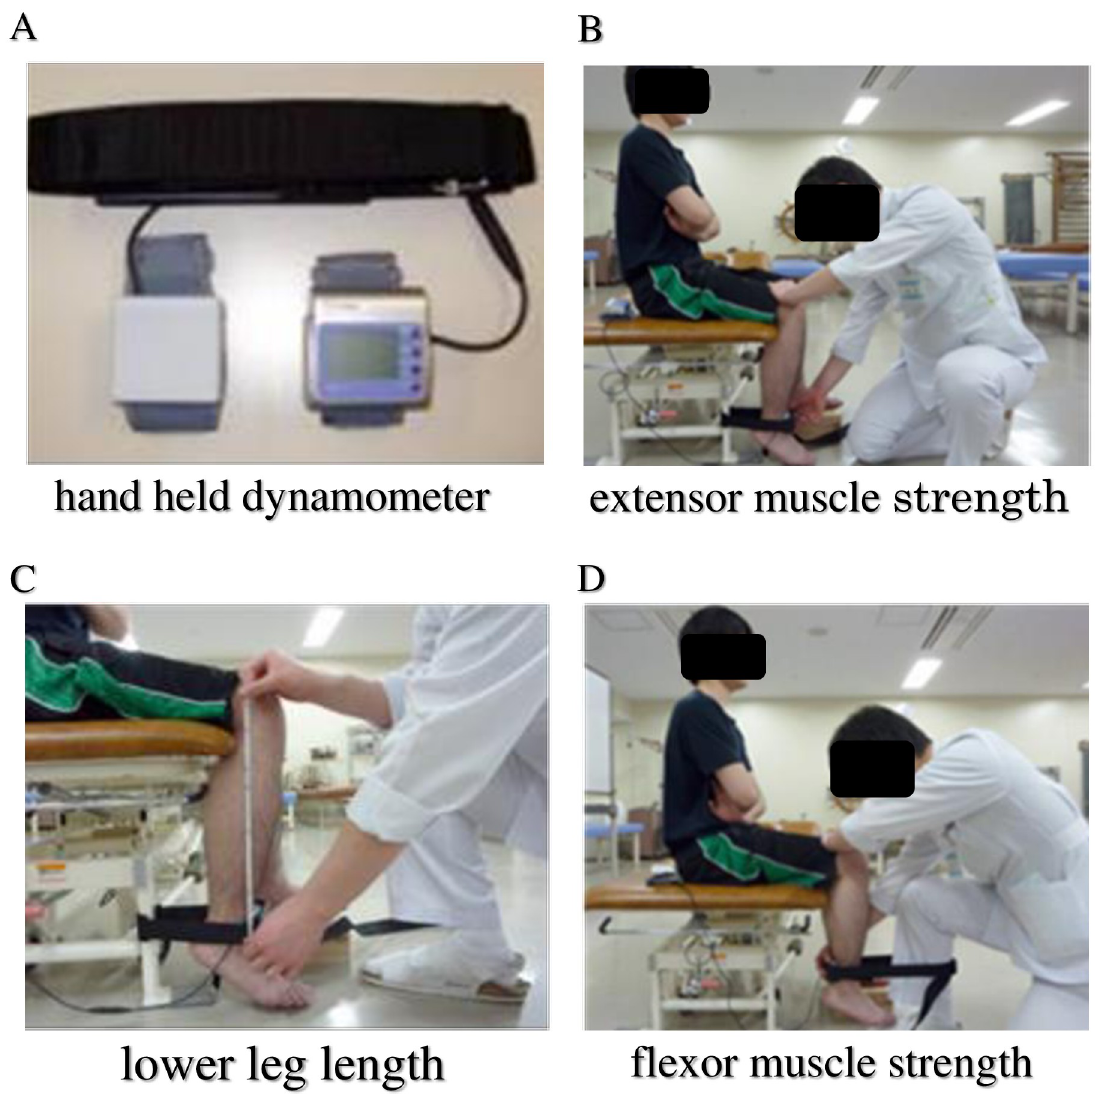
Fig 2. Measurement of knee extensor/flexor muscle strength. The measurement was performed by use of a hand-held dynamometer (HHD) [A]. For measuring extension muscle strength [B], the examinee sitting on chair with the knee joint bent at 90-degree angle was asked to extend the lower leg at maximum force against the black belt around the ankle, which was fixed behind to the chair with the HHD attached to its front. The length of the lower leg (Len in meter) was measured [C] as a distance between the lateral cleft of the knee joint and the center of the HHD sensor at the ankle. The muscle strength in N � m was computed as a product of HHD output (N) and leg length (m). Similarly, the flexion muscle strength was measured [D] by forcibly flexing the lower leg with the belt fixed to the leg of the examiner and the HHD attached at the back side of the